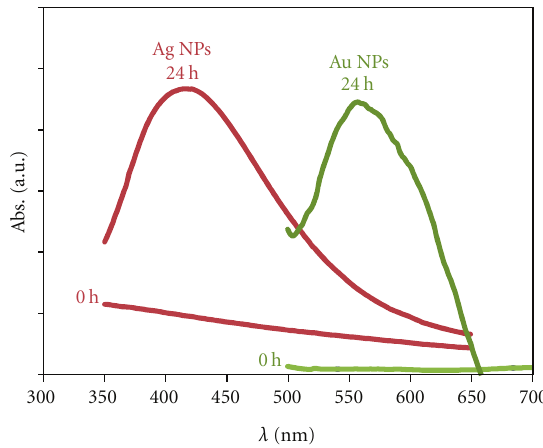
Figure 2: UV-Vis spectra recorded with respect to time after the reaction 0h and 24h of contact with yeast biomass with 1mM AgNO 3 (red line) and 0.6 mM HAuCl 4 (green